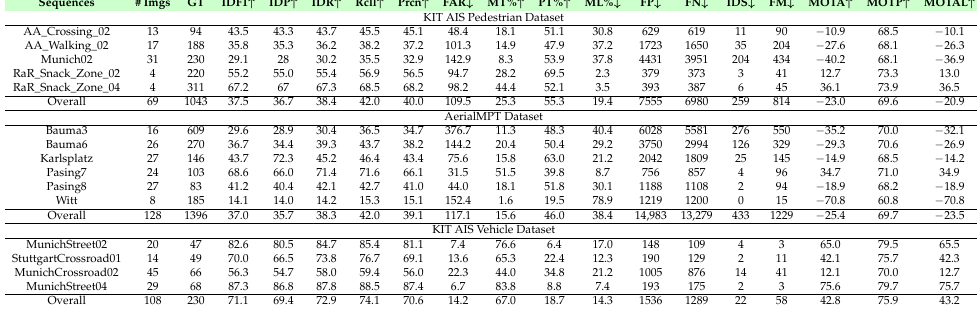
Table 13. AerialMPTNet GCNN on the KIT AIS and AerialMPT datasets. Sequences